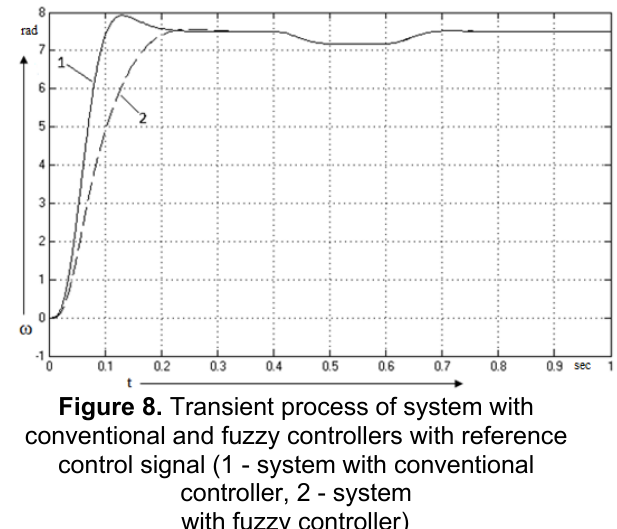
Figure 8. Transient process of system with